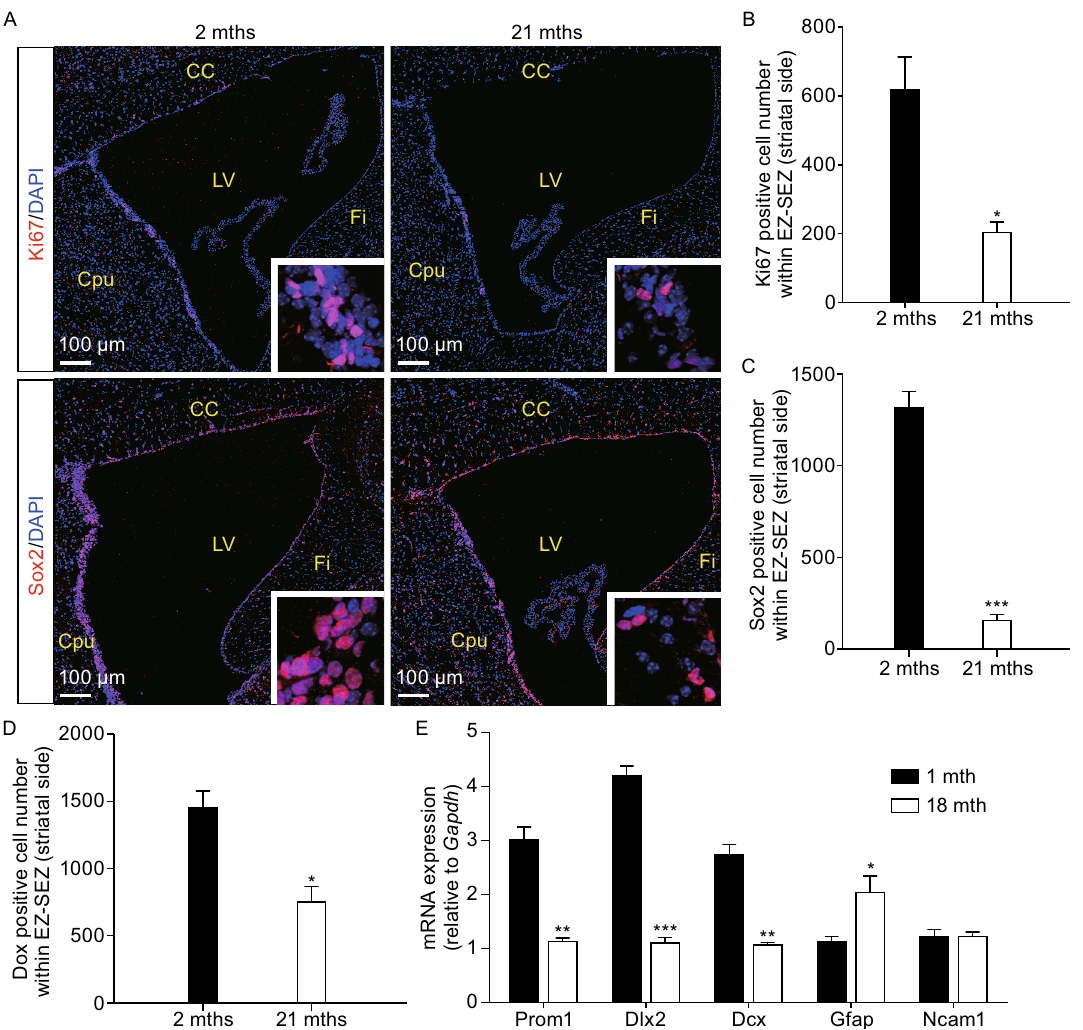
Figure 2. Reduced cell proliferation and neurogenesis in aged mouse forebrain neurogenic zone. (A) Micrographs of sagittal sections from young (2 mths) and old (21 mths) mouse EZ-SEZ/SVZ region immunostained with a proliferation marker Ki67 and a neural stem cell marker Sox2. The insets respectively indicate Ki67 and Sox2 positive cells. (B – D) Quanti fi cation of Ki67, Sox2, Dcx positive cells in young and old mouse EZ-SEZ/SVZ region lining the striatal side ( n ≥ 3 per age group, see MATERIALS AND METHODS). (E) The mRNA expression of several NPC marker genes ( Prom1 , Dlx2 , Dcx , Gfap , and Ncam1 ) were measured by qPCR of total RNA extracted from young (1 mth) and old (18 mths) mouse EZ-SEZ/SVZ tissues ( n = 3 per group). Error bars indicate the SEM from three independent experiments. * P < 0.05; ** P < 0.01; *** P < 0.001. CC, corpus callosum; Cpu, caudate putamen; LV, lateral ventricle; Fi, fi mbria of the